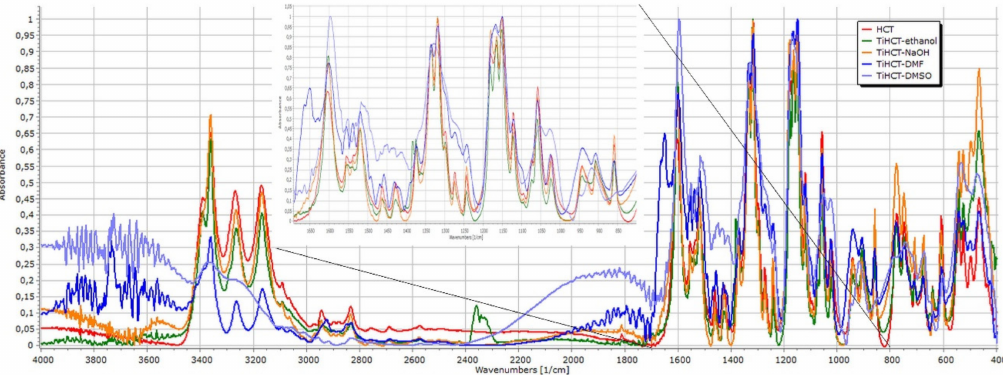
Figure 10. FT-IR spectra of HCT and its